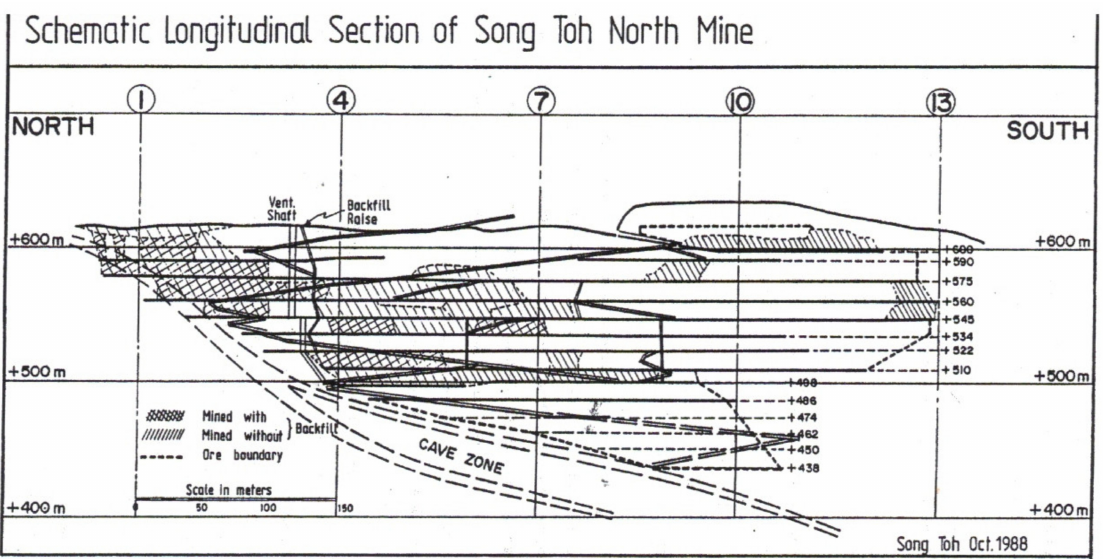
Figure 12. Cross section of the Song Toh Mine (status October 1988) (from [48] (with permission of the